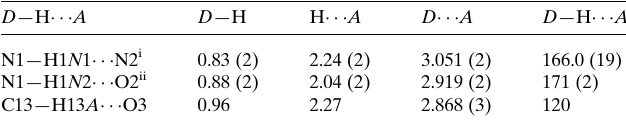
Table 1 Hydrogen-bond geometry (A˚ , (cid:3) ).